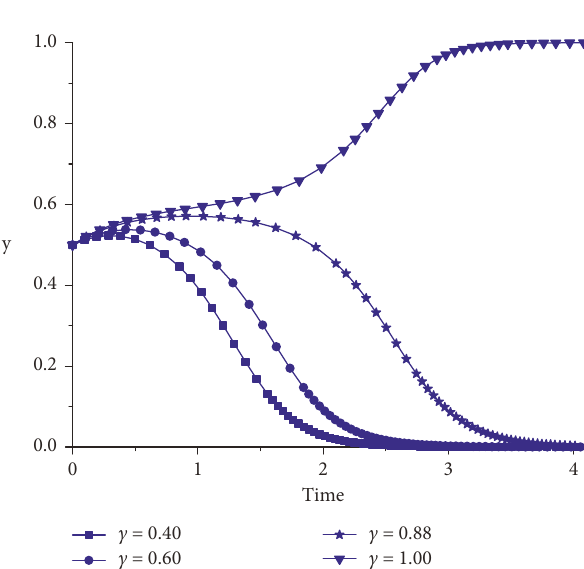
Figure 15: Impact of risk preference coefficient on enterprise 2.